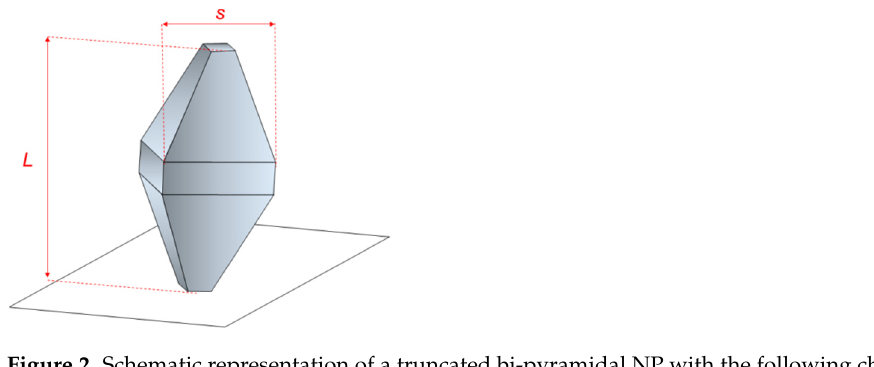
Figure 2. Schematic representation of a truncated bi ‐ pyramidal NP with the following characteristic parameters: (i) L, length, (ii) s, side of the square base, (iii) major axis truncation and (iv) minor axis truncation.